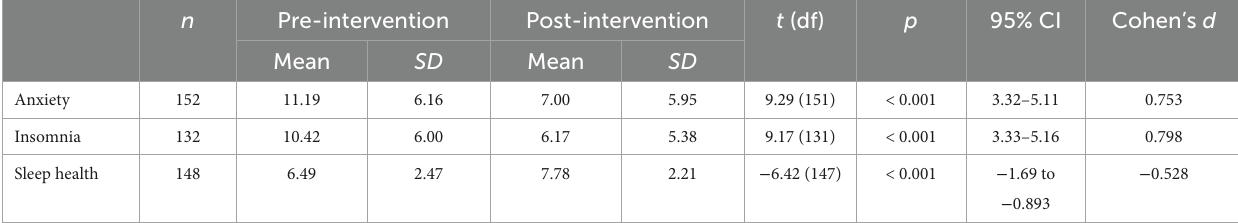
TABLE 3 Descriptive statistics and paired samples t -tests regarding intervention effects on anxiety, insomnia, and sleep health from pre- to post- intervention. n